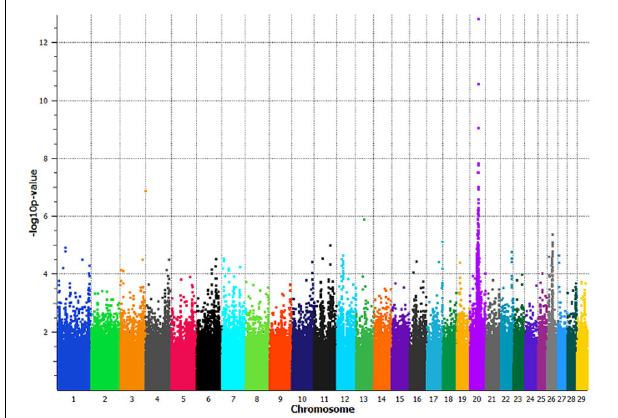
FIGURE 2 | Manhattan plot of a genome-wide association study comparing slick-haired tropical breeds and cross-bred lineages to non-slick-haired ancestral breeds. Seventy-two slick-haired animals from the tropical breeds of Senepol, Carora, Romosinuano and cross-bred lineages were compoared to 61 non-slick animals from Red Poll, Brown Swiss, Holstein, Angus, N’Dama, and East African Zebu ancestral breeds. Non-slick individuals from the cross-bred lineages were included with the ancestral control breeds. Significant association of the slick phenotype was found on BTA20 at 38.5Mb with the peak SNP having a p -value of 1 . 54 × 10 − 13 using a panel of 639,663 SNPs spanning all bovine autosomes. The x-axis denotes chromosome 1 through 29 with SNP positions plotted in increasing genomic order. The y-axis plots the − log 10 p -value as determined in an association analysis using the program